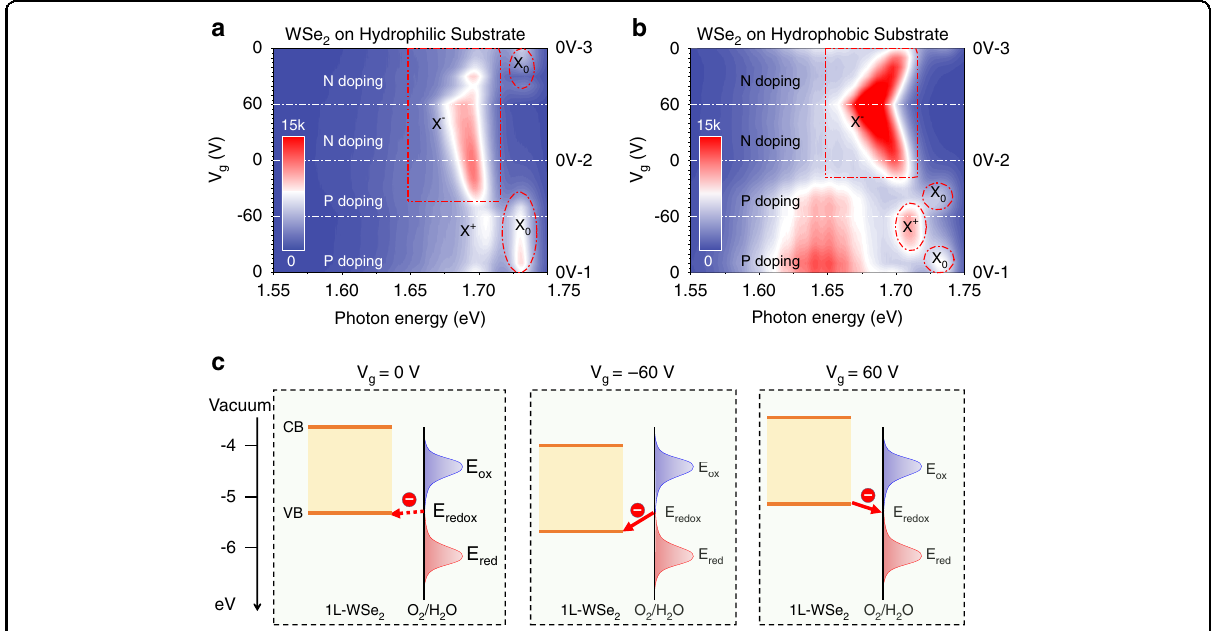
Fig. 3 Mechanism of the excitonic hysteresis. a Contour plot for the PL spectra of monolayer WSe 2 as a function of cyclic V g . The spectra were acquired in the individual WSe 2 region of the HS on a hydrophilic substrate. b Contour plot for the PL spectra of monolayer WSe 2 on a hydrophobic substrate, which is functionalized by hexamethyldisilazane (HDMS). The PL measurements were conducted at 78 K with 532 nm laser excitation (23 μ W). c Illustration of chemical doping caused by O 2 /H 2 O molecules. The electronic density of states (DOS) re fl ect the electron energy distribution around the oxidation potential ( E ox ) and reduction potential ( E red ), respectively. E redox is the energy where the DOS of reducing and oxidizing species are equal: D ox ( E redox ) = D red ( E redox